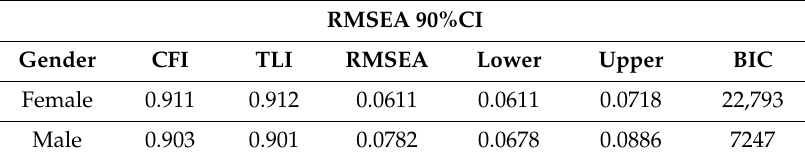
Table 2. Fit measures of confirmatory factor analysis (CFA) females vs. males. CFI: comparative fit index, TLI: Tucker–Lewis index, RMSEA: root mean square error of approximation and BIC: Bayesian information